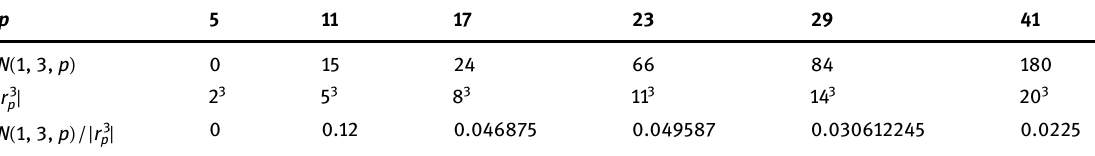
Table 1: Density of solution number in r p